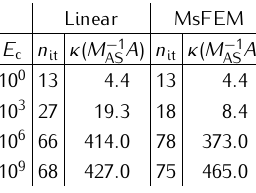
Table 5. Iteration numbers n and condition numbers κ ( M − 1 A ) for Experiment 3; geometry: 1 /h× 1 /h×H/h , h = 1 / 240 , H = 12 h ; linear and it AS multiscale coarsening for different contrasts E